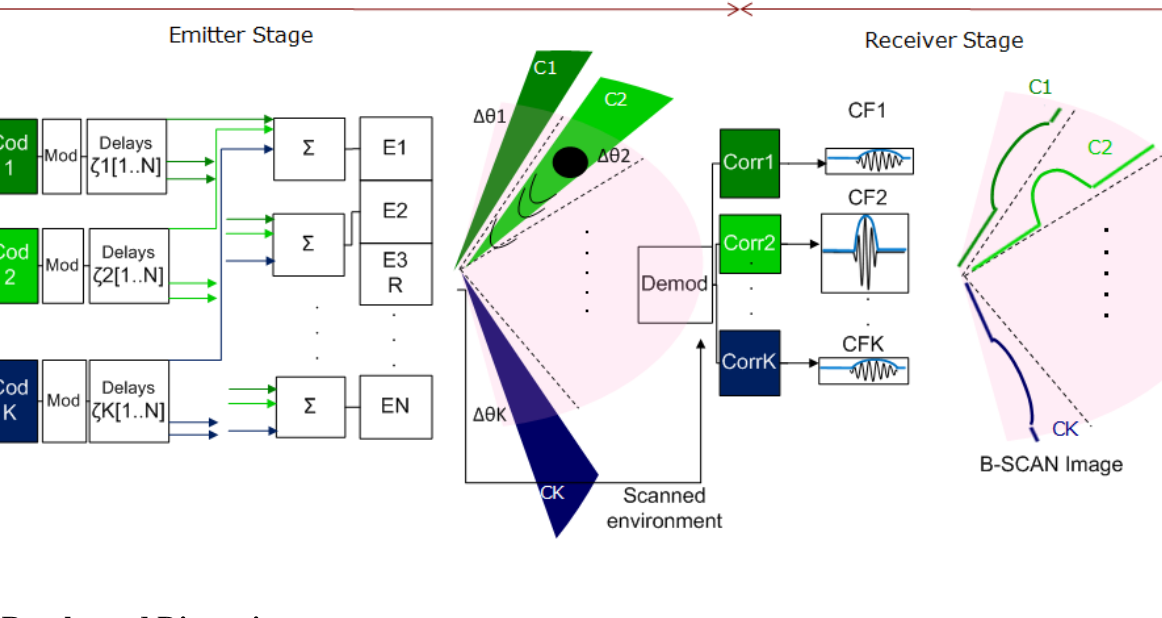
Figure 7. Full system scheme when a reflector is placed in angular sector ∆ θ